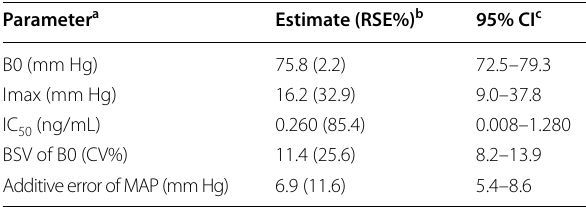
Table 3 Parameter estimates of the MAP Imax model